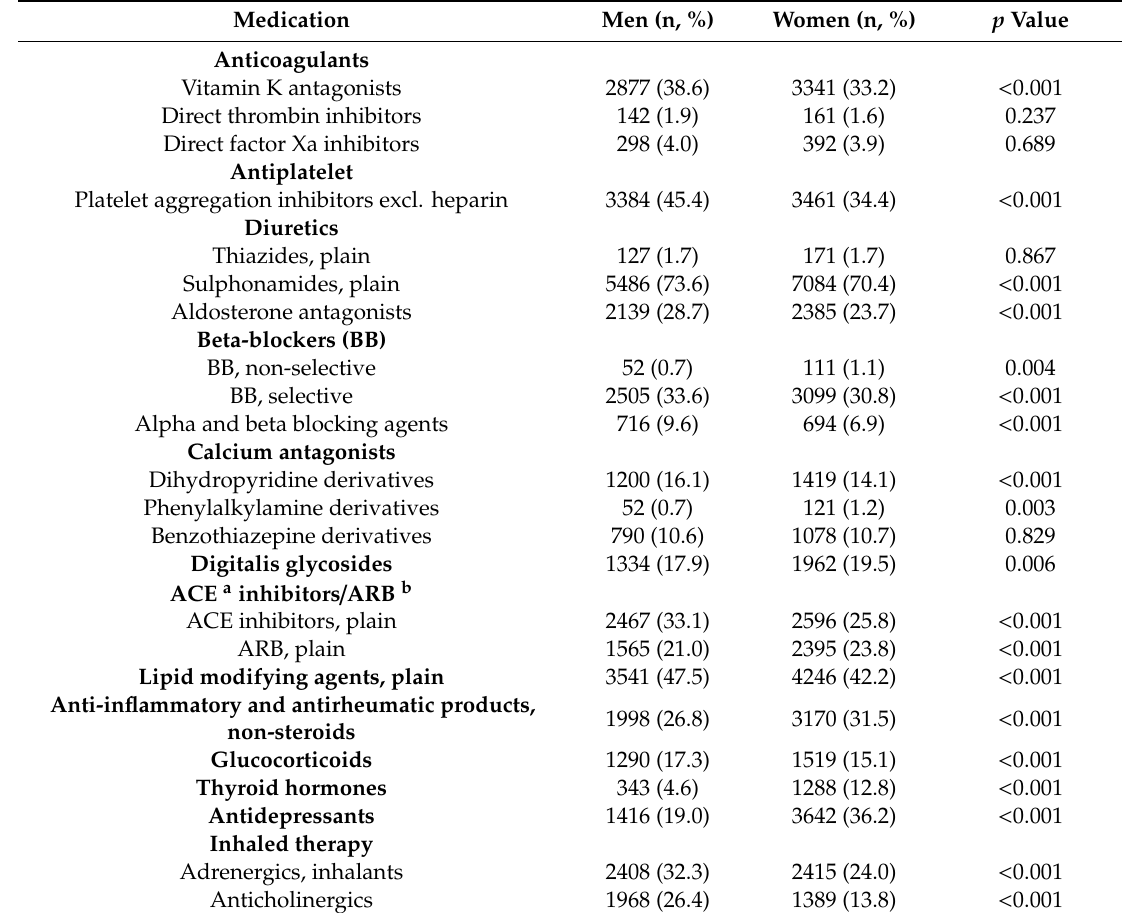
Table 3. Di ff erences in drug dispensation between men ( n = 7454) and women ( n = 10,062) with heart failure. Age-adjusted dispensation rates of drugs of interest are